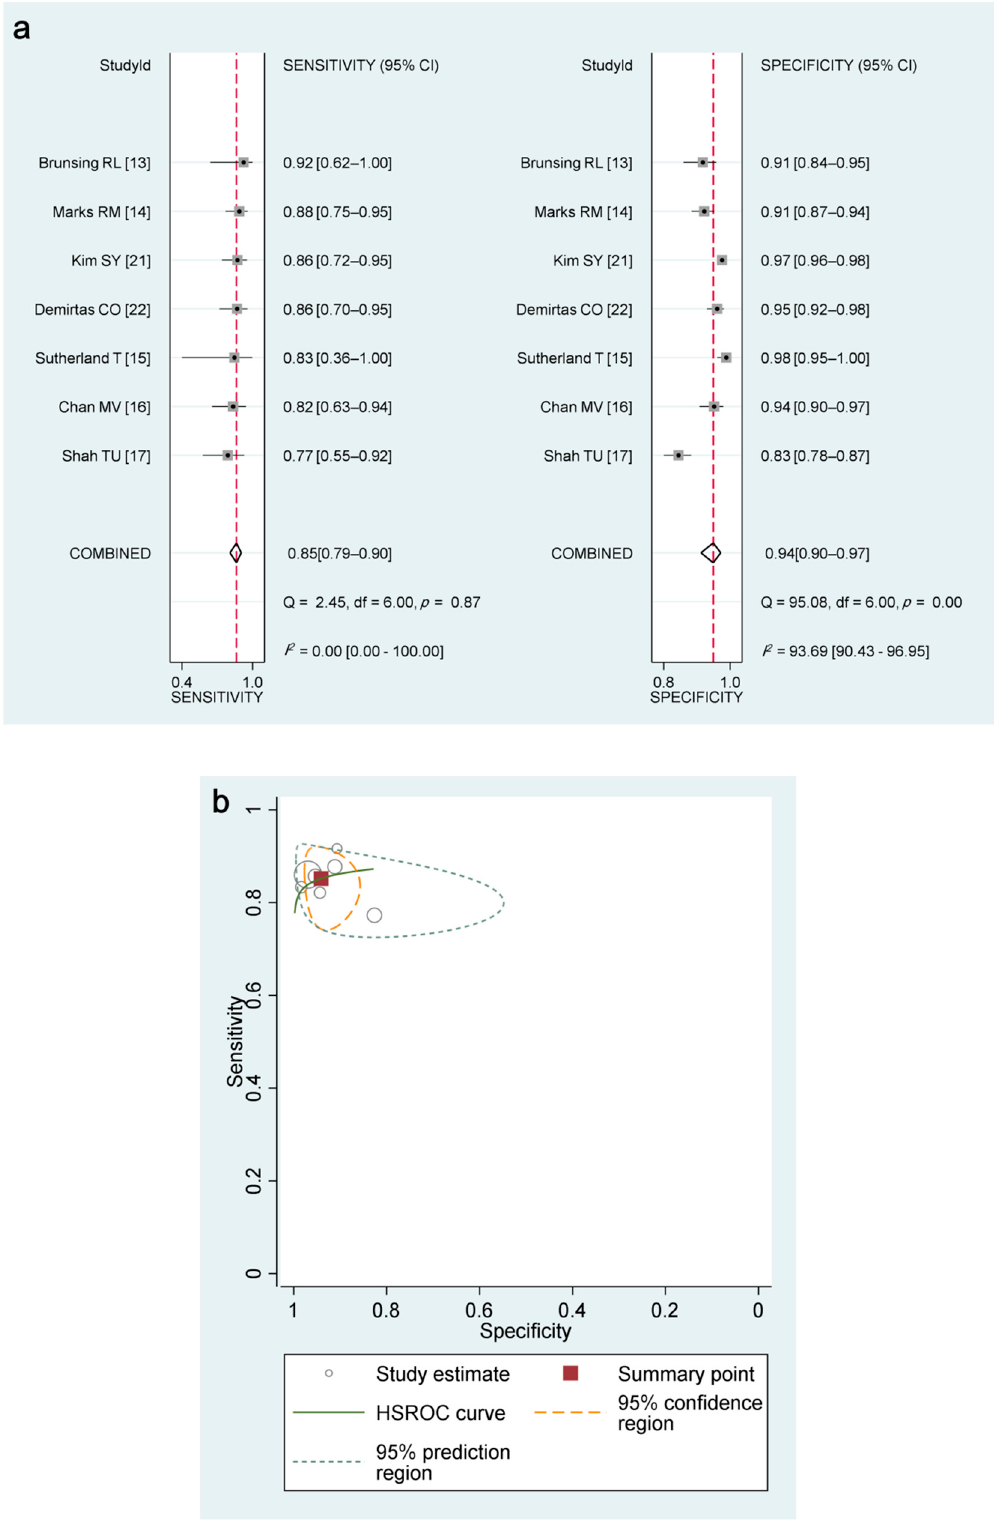
Figure 3. Coupled forest plots and HSROC curve for sMRI. ( a ) The quadrilateral of the combined row in the coupled forest plots represents the pooled estimation and its 95% confidence interval. ( b ) The large difference between 95% confidence region and 95% prediction region in HSROC curve indicates the presence of substantial study heterogeneity.